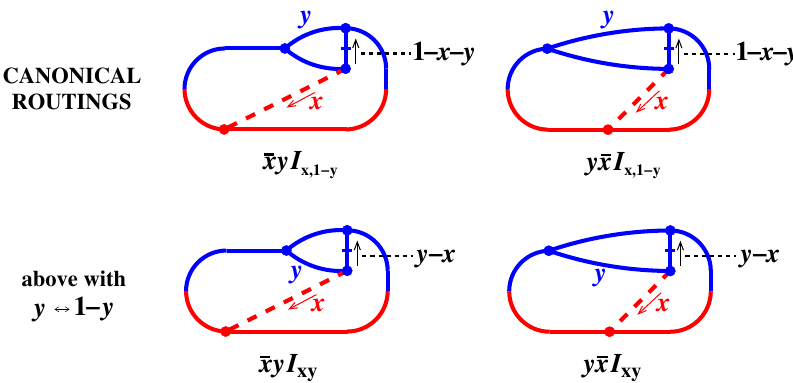
Figure 16 . Diagrams with infrared divergences associated with longitudinally polarized gluon exchange. The divergences occur at either y → 1 − x (top line) or y → x (bottom line).